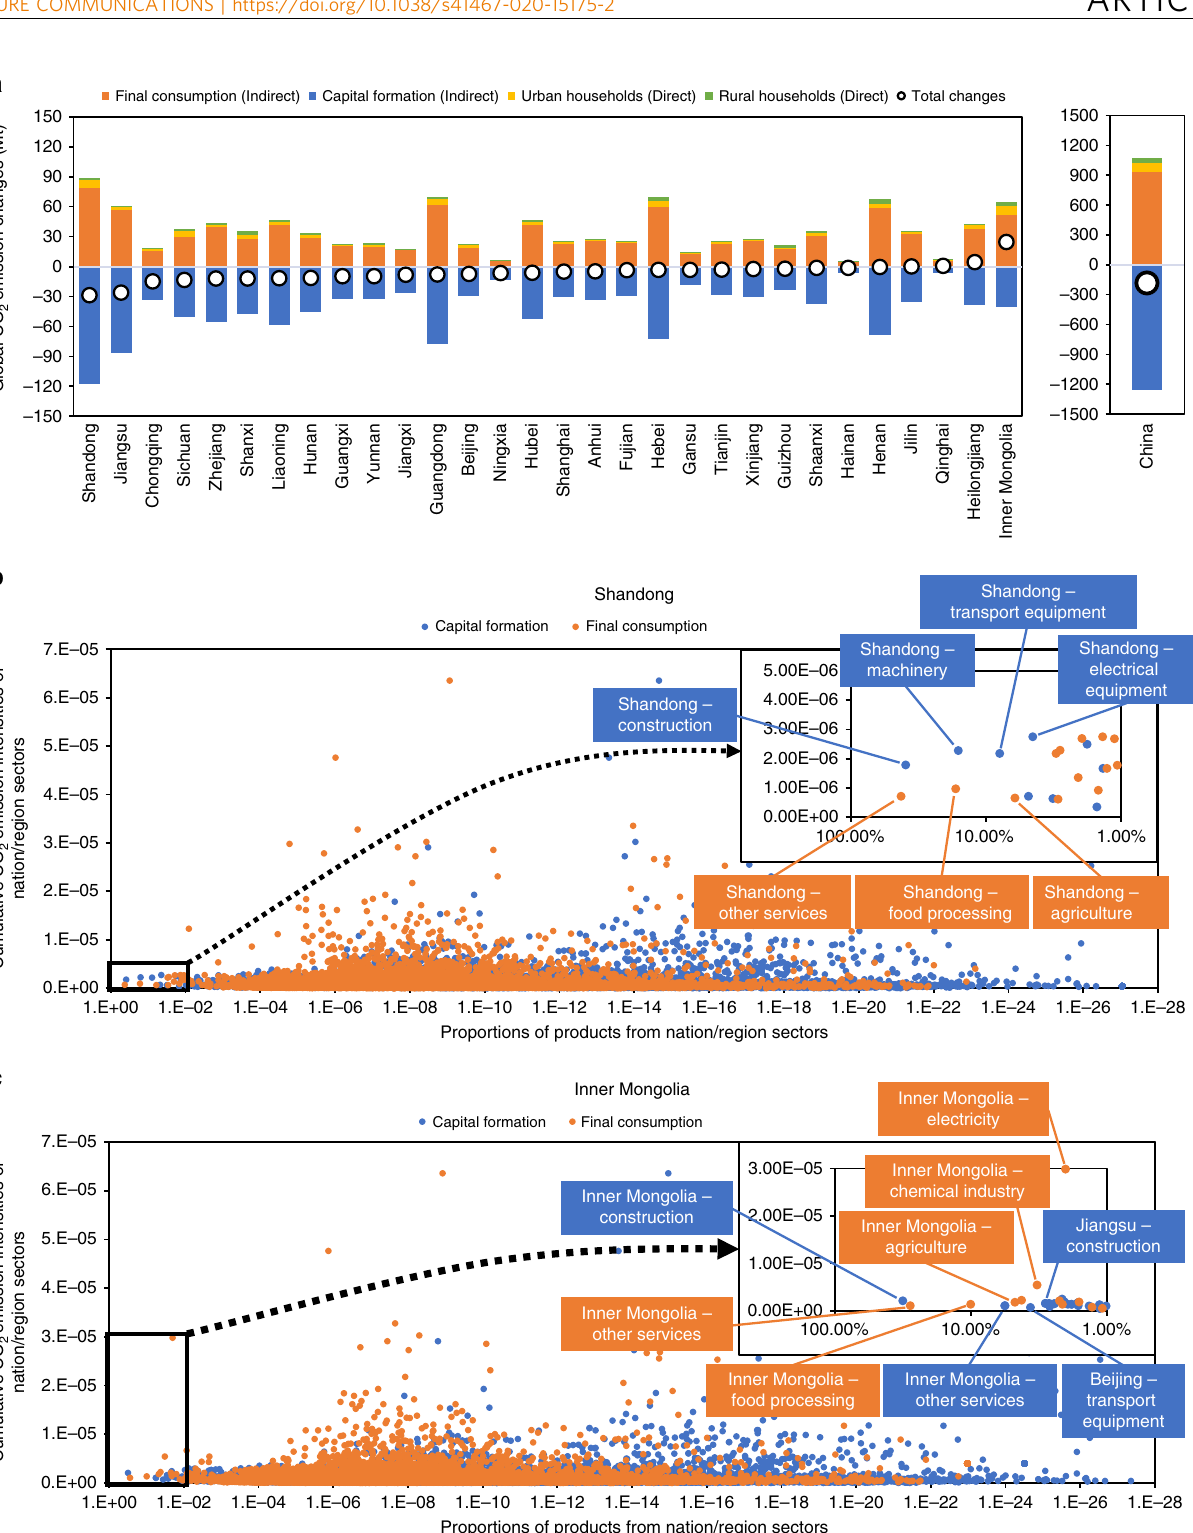
Fig. 5 Global CO 2 emission changes caused by reducing the saving rate of each Chinese region by 15-percentage points and the particular situations for Shandong and Inner Mongolia. Panel a shows global CO 2 emission changes caused by reducing the saving rate of each Chinese region by 15- percentage points. Panels b , c show particular situations for Shandong and Inner Mongolia, respectively. The horizontal axis in b , c represents the proportions of products from nation/region-sectors in fi nal consumption or capital formation, and the vertical axis represents the cumulative CO 2 emission intensities of